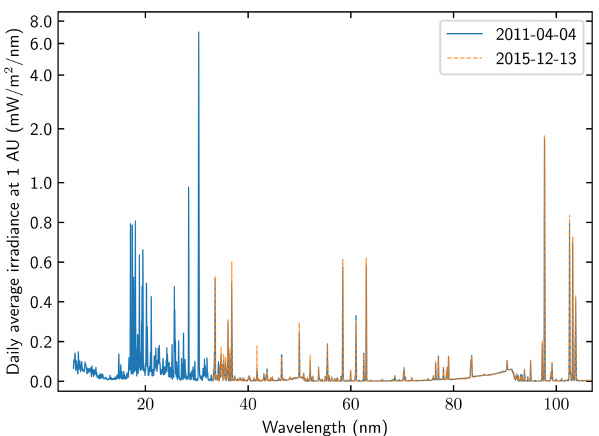
Figure 3. Measurements of daily average irradiance at 1AU from the EVE instrument from the day of the launch 13 December 2015 (orange) and the closest match to the launch day from when the MEGS-A detector worked (blue). Notice that the irradiance scale is linear below 1mWm − 2 nm − 1 and logarithmic